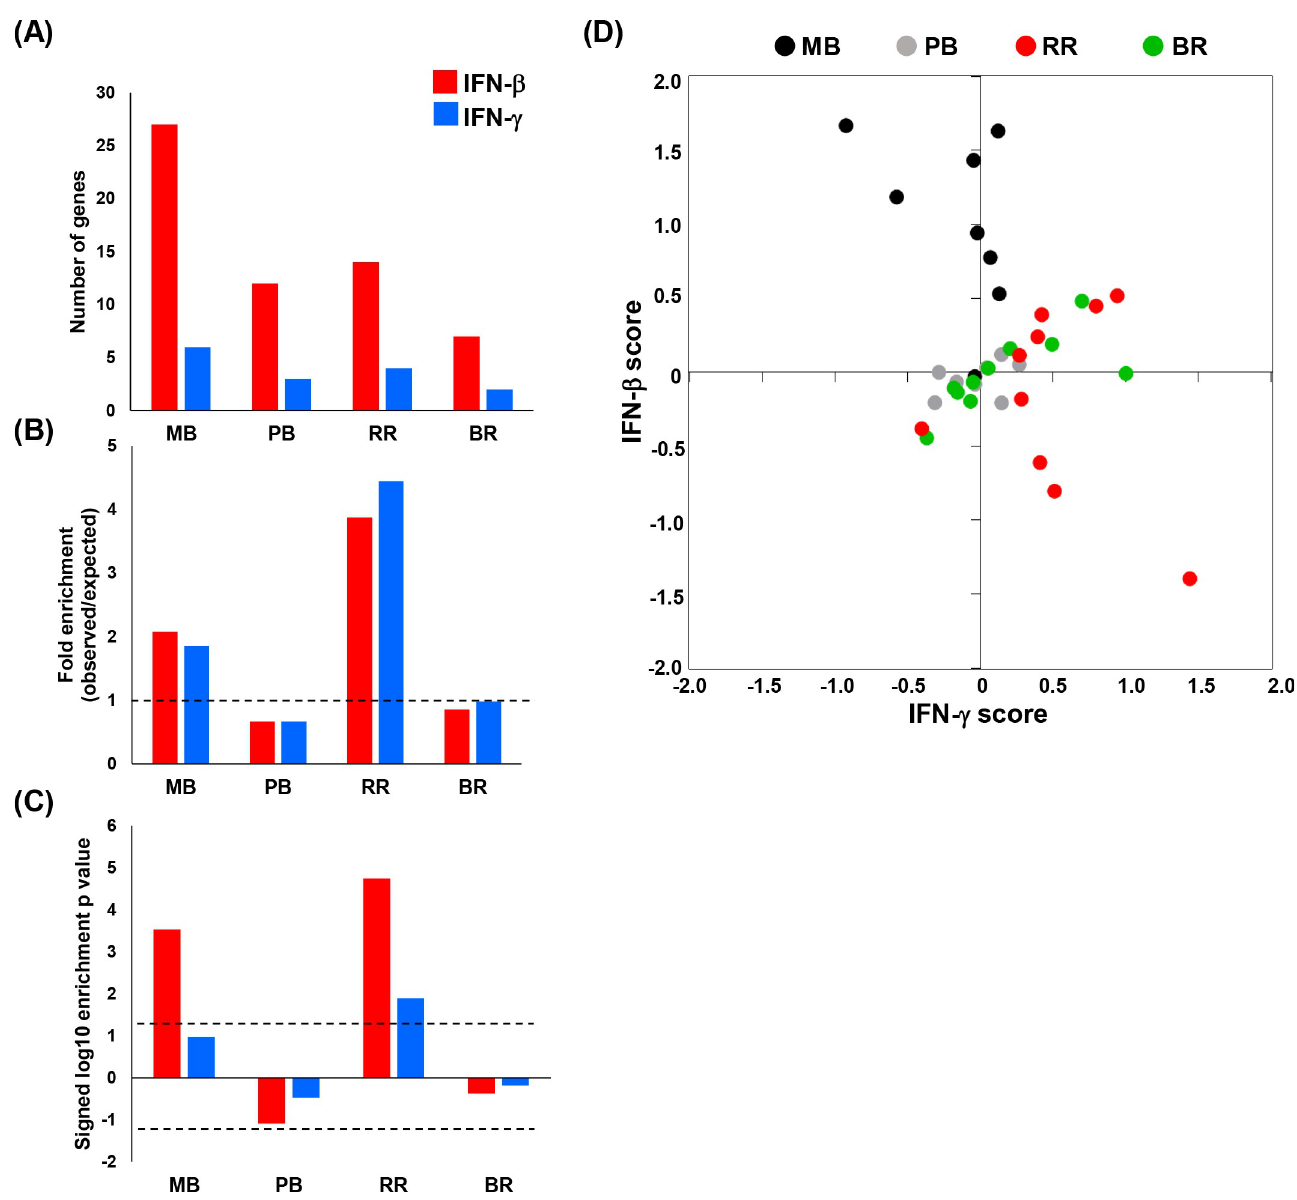
Fig 3. IFN- β and IFN- γ specific downstream gene signature for all leprosy subtypes. (A-C) Enrichment analysis of overlap between IFN- β and IFN γ –specific upregulated genes identified in human MDMs and MB, BR, RR and PB leprosy whole blood transcripts (PM = top 500 genes). The top graph shows the number of overlapped genes between each leprosy clinical form and IFN- β and IFN- γ specific genes (A). Dotted lines indicate either the expected fold enrichment of one (middle—B) or the hypergeometric enrichment p-value of 0.05 (log P = 1.3, bottom—C). Hypergeometric analyses were performed to determine fold enrichment (observed/expected) and signed log enrichment p-value (negative for de-enriched). The Bonferroni multiple hypothesis test correction was applied for each group. (D) IFN- β and IFN- γ specific gene voting summation scores were calculated for an individual patient blood sample in leprosy states MB (n = 8), BR (n = 10), RR (n = 10) and PB (n = 8). MB = multibacillary, BR = before reaction, RR = reversal reaction and PB =